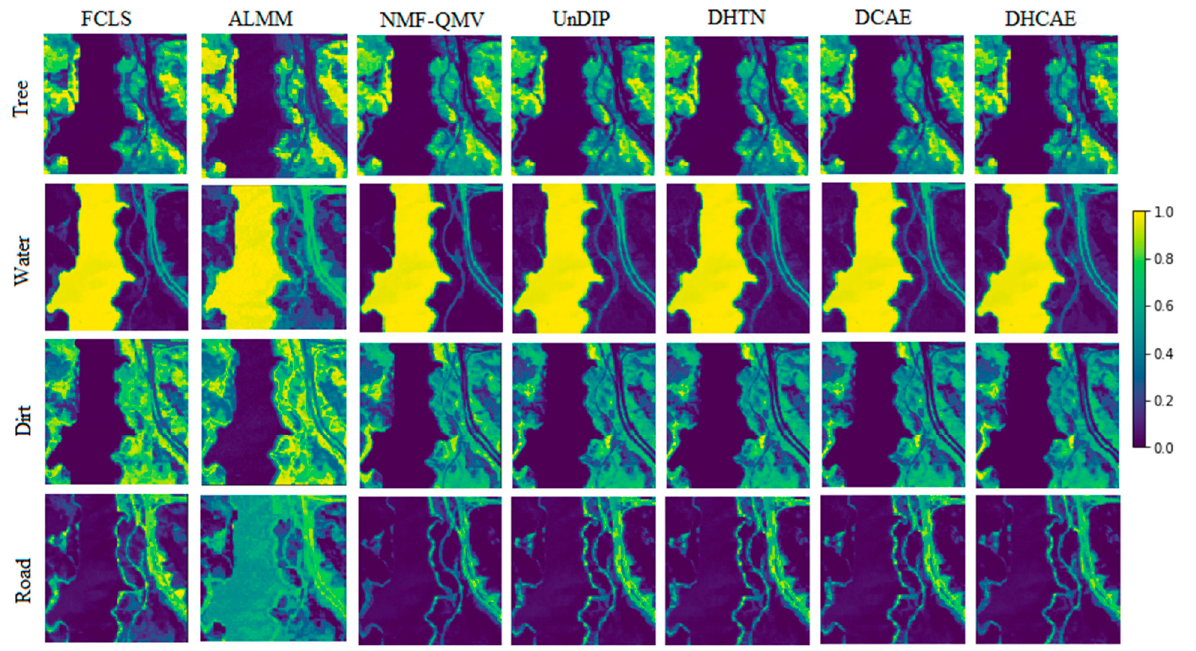
Figure 10. Jasper Ridge data. Comparison of extracted abundance maps with noisy bands by different spectral unmixing methods.